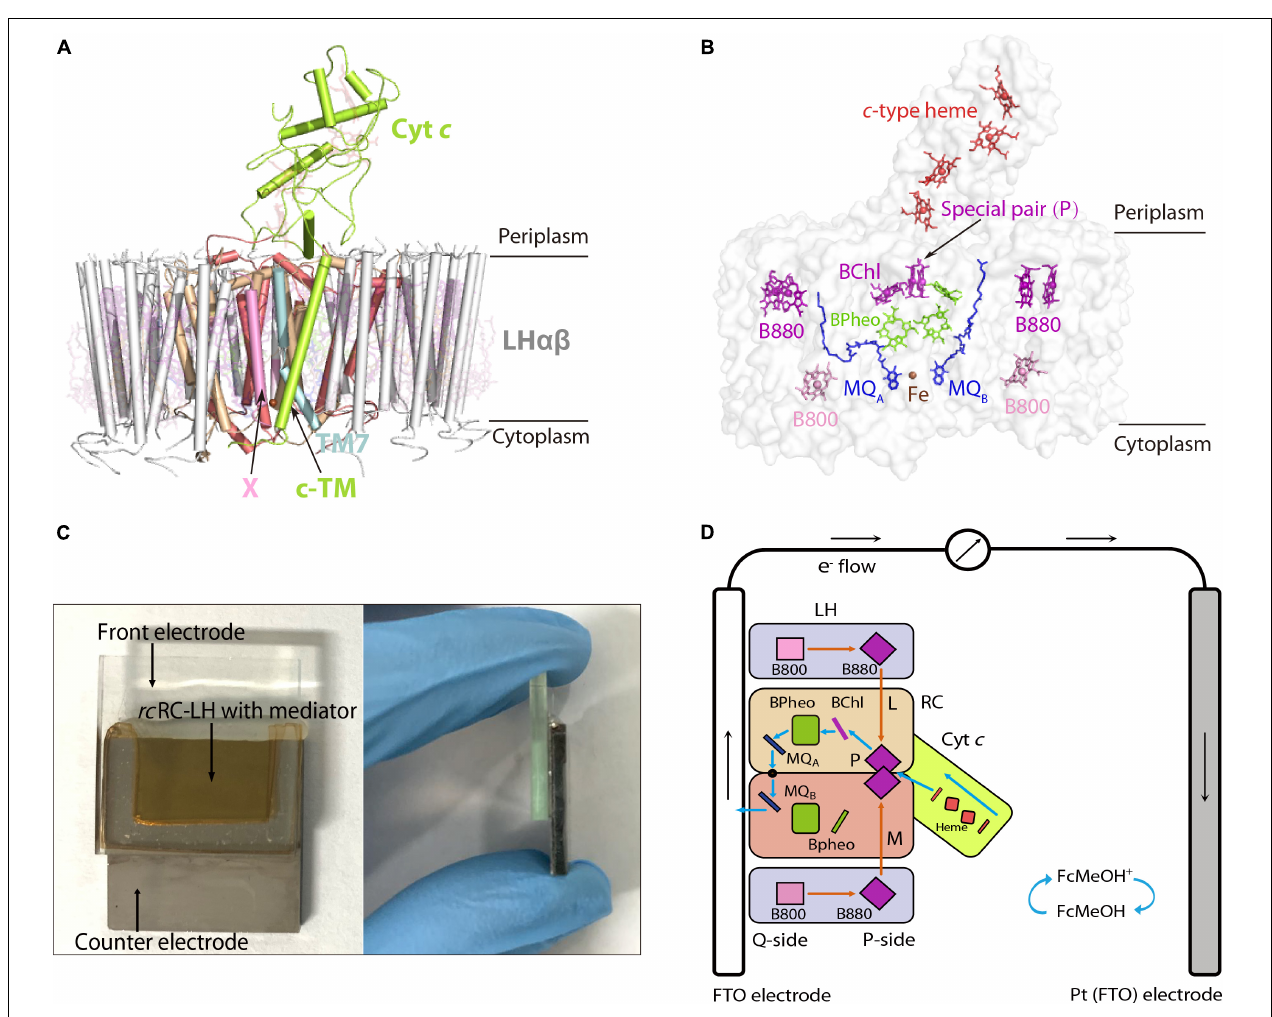
FIGURE 1 | Preparation of an FTO-Pt PBEC using the RC-LH from R. castenholzii (rcRC-LH) rc . (A) Overall structure of the rc RC-LH (PDB ID: 5YQ7) is shown at the side view. The light harvesting (LH) complex (white) is composed of 15 LH αβ heterodimers in the form of an opened elliptical ring, which encircles the L (wheat), M (salmon), and cyt c subunit (limon) composed RC. The tetraheme (red sticks) binding domain of the cyt c subunit is exposed at the periplasmic side. Especially, a novel transmembrane helix of the cyt c (c-TM) inserts into the gap of the LH ring, and form a quinol shuttling channel in together with a newly identified X subunit (pink). An unassigned TM7 transmembrane helix (light cyan) is identified near the transmembrane helices of the L and M subunits in the RC. All the cofactors are shown as stick models with a transparency at 80%. (B) Spatial organization of the pigments and electron carriers in the rc RC-LH. Each LH αβ non-covalently binds two B880s (purple) at the periplasmic side, one B800 (pink) at the cytoplasmic side. The RC accommodates a special pair of BChls (P, purple), an accessary BChl (purple), and three BPheos (chartreuse), as well as an iron (brown sphere) and two menaquinone-11 (MQ, blue) molecules. The four c -type hemes bound in the cyt c subunit are exposed in the periplasmic side. All the cofactors except the iron are shown as stick models. (C) Construction of the rc RC-LH based FTO-Pt PBEC. The PBEC is composed of a FTO glass as the front electrode and a Pt-coated FTO glass as the counter electrode, a mixed solution of rc RC-LH with the mediator is injected into the cavity between the two electrodes as the electrolyte. A front (left) and side (right) view of the apparatus is shown. (D) Diagram of the operating mechanism of the rc RC-LH prepared FTO-Pt PBEC. The electron donor FcMeOH (hydroxymethylferrocene) was used as the mediator. Orange arrows indicate the route of light energy transfer, and blue arrows indicate the route of electron transfer. The P-side represents the direction of the rc RC-LH wherein the special pair (P) is located, and the direction where the MQ A and MQ B located is named the Q-side. The photogenerated electrons released from the excited P + are transferred along the accessary BChl, BPheo to Q A , an iron, then to Q B . The electrons at the Q B directly enter the front electrode (FTO) and are transferred to the counter electrode (Pt), wherein the accepted electrons pass through the c -type hemes via the mediator to reduce the excited P + and form a steady-state